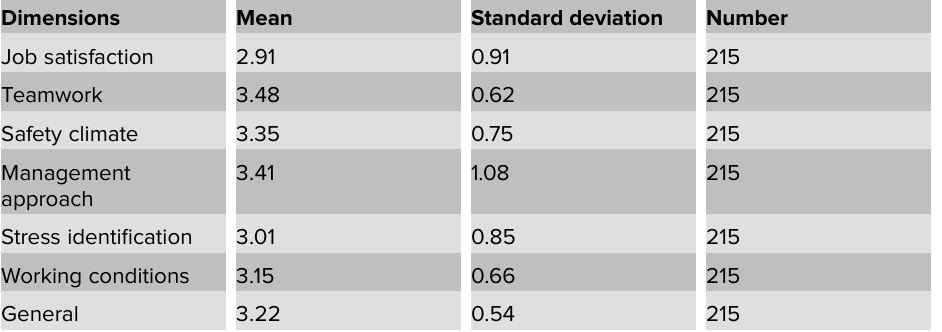
Table 3: Statistics on patient safety attitude